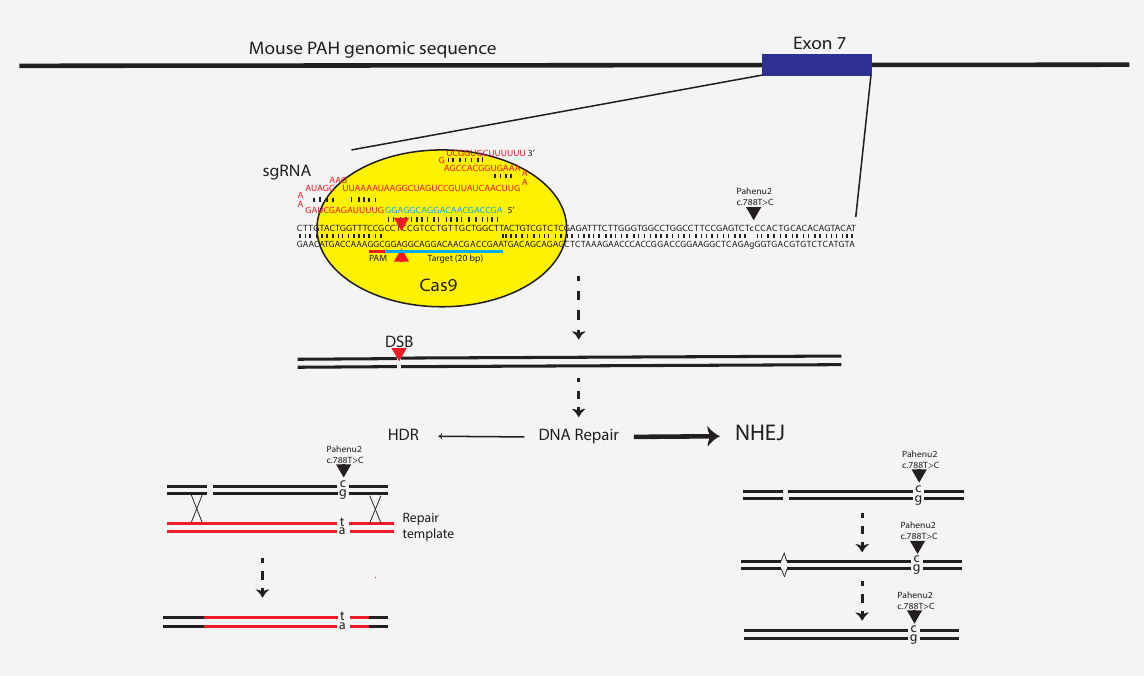
Figure 4. Site specifi c CRISPR/Cas9-mediated double strand breakage in the Pah gene and the critical choice of DNA repair pathway for editing of the Pah enu2 mutation. We designed a CRISPR/Cas9-mediated strategy to attempt to repair the Pah enu2 mutation in PKU mice. The Pah enu2 mutation is a T to C change at nucleotide position 788 (relative to the translation start site of the Pah cDNA) residing in exon 7 of the Pah gene. We designed a single guide RNA (sgRNA) that directs binding of the Cas9 endonuclease to a position just upstream from the Pah enu2 mutation site. Cas9 induces a double strand break (DSB) at this specifi c location. Competing innate cellular DNA repair mechanisms then seek to repair the DSB. The predominant repair mechanism is Non-Homologous End Joining (NHEJ), which can either perfectly repair the DSB yielding the original unaltered DNA sequence or may introduce small deletions or duplications (indels) further disrupting the gene. Neither of these events results in restoration of a functional Pah gene. Alternatively, in the presence of a double stranded DNA repair template that harbors the wild type sequence at the site of the targeted mutation, a small percentage of genomes may be repaired through Homology Directed Repair (HDR). In successful HDR, a segment of the chromosome harboring the DSB and the Pah enu2 mutation is replaced by the repair template sequence leading to correction of the mutation and restoration of PAH